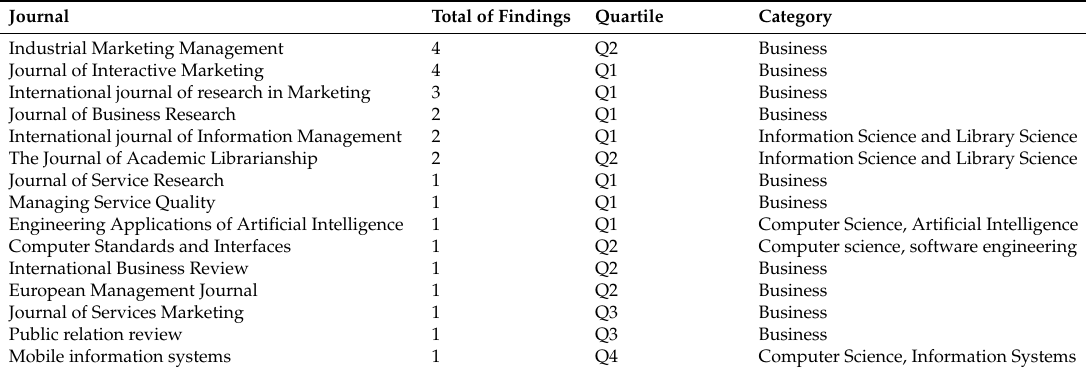
Table 3. Analysis of